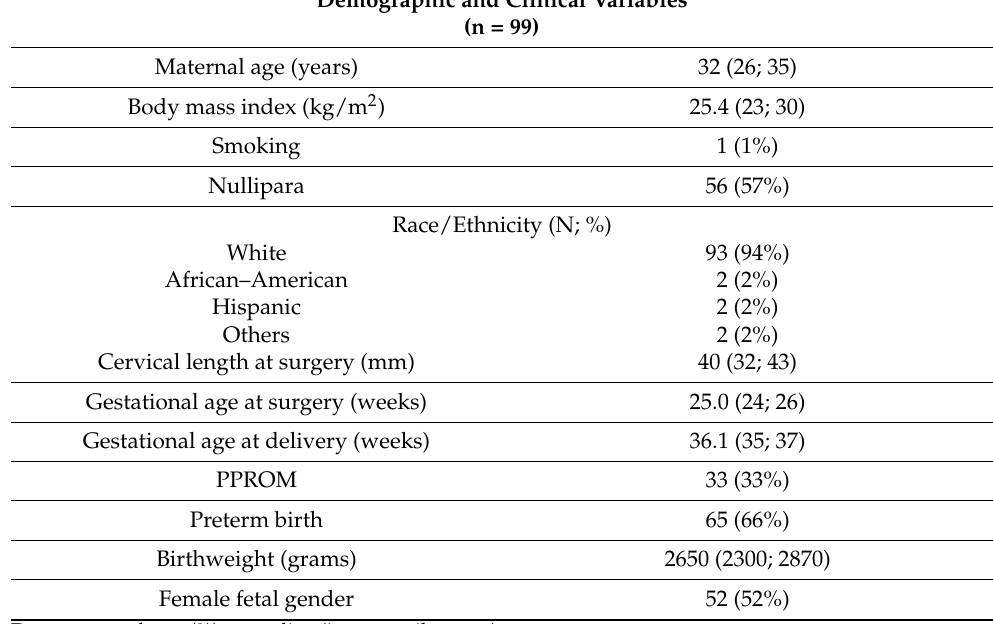
Table 1. Demographic and Clinical